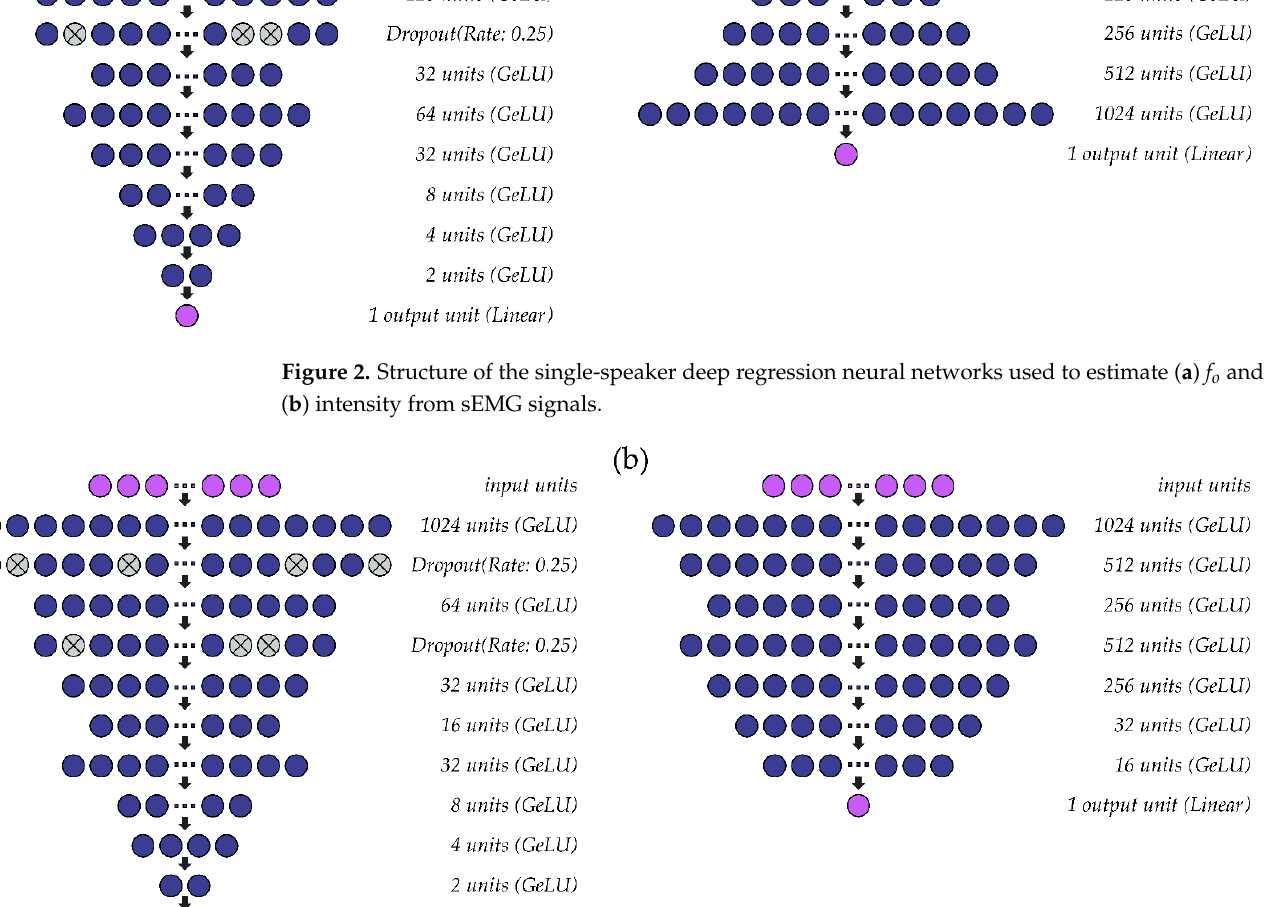
Figure 2. Structure of the single-speaker deep regression neural networks used to estimate ( a ) f o and ( b ) intensity from sEMG signals.